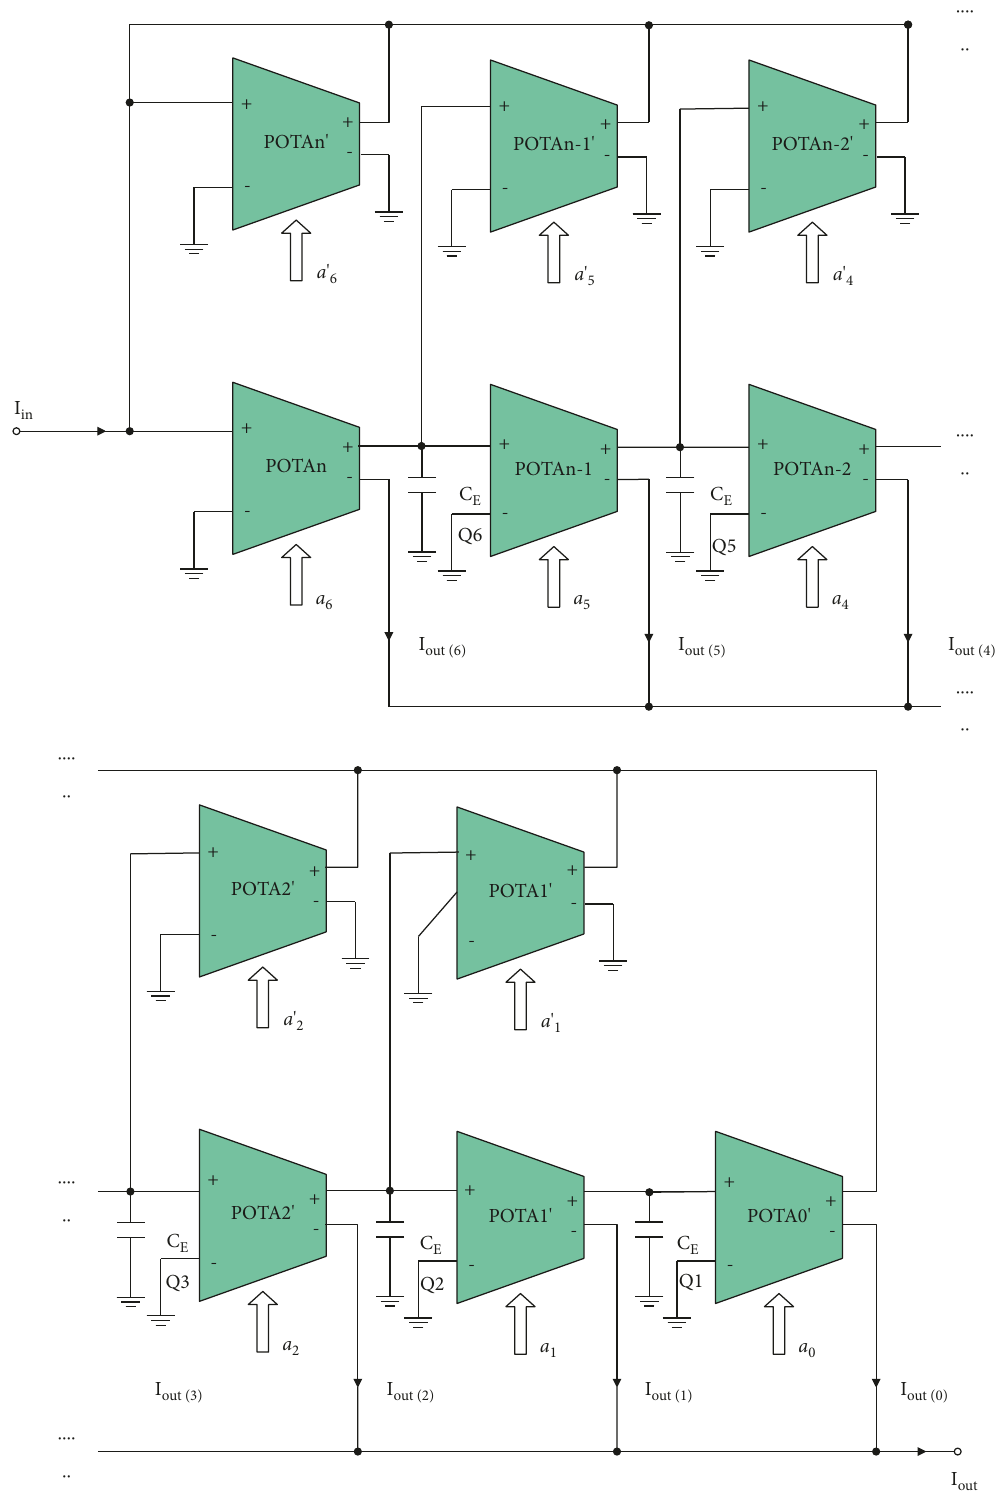
Figure 8: Schematic diagram of high-order general-purpose